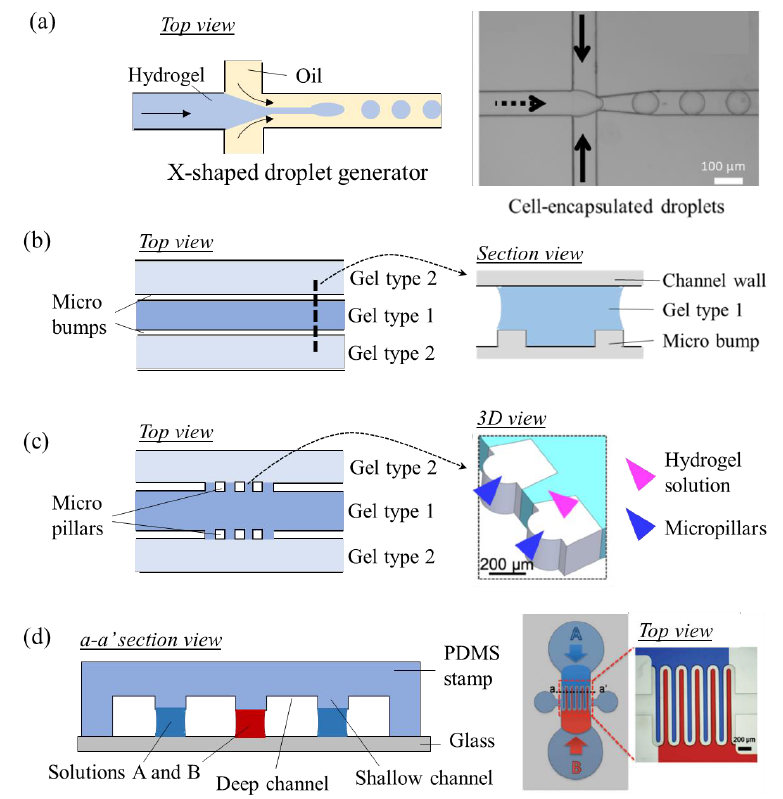
Figure 3. Methods used for positioning cells with in-vivo-like layouts. ( a ) Schematics of a droplet- based microfluidic device for culturing single-cells in droplets. The right panel figure is reproduced from Chan et al., 2013 [30]. ( b ) Schematics of a microchannel with micro bumps, allowing for the injection of different hydrogel types without physically dividing the channel. ( c ) Schematics of micropillars working as capillary valves. The right panel figure is reproduced from Hyung et al., 2021 [37]. ( d ) Schematics of capillarity-mediated liquid patterning. Shallow channels with hydrophilic regions attract the solution while hydrophobic regions repel the solution with water content. Shallow channels guide cells to be patterned in designed shapes. Figure reproduced from Lee et al. (2010) [43].